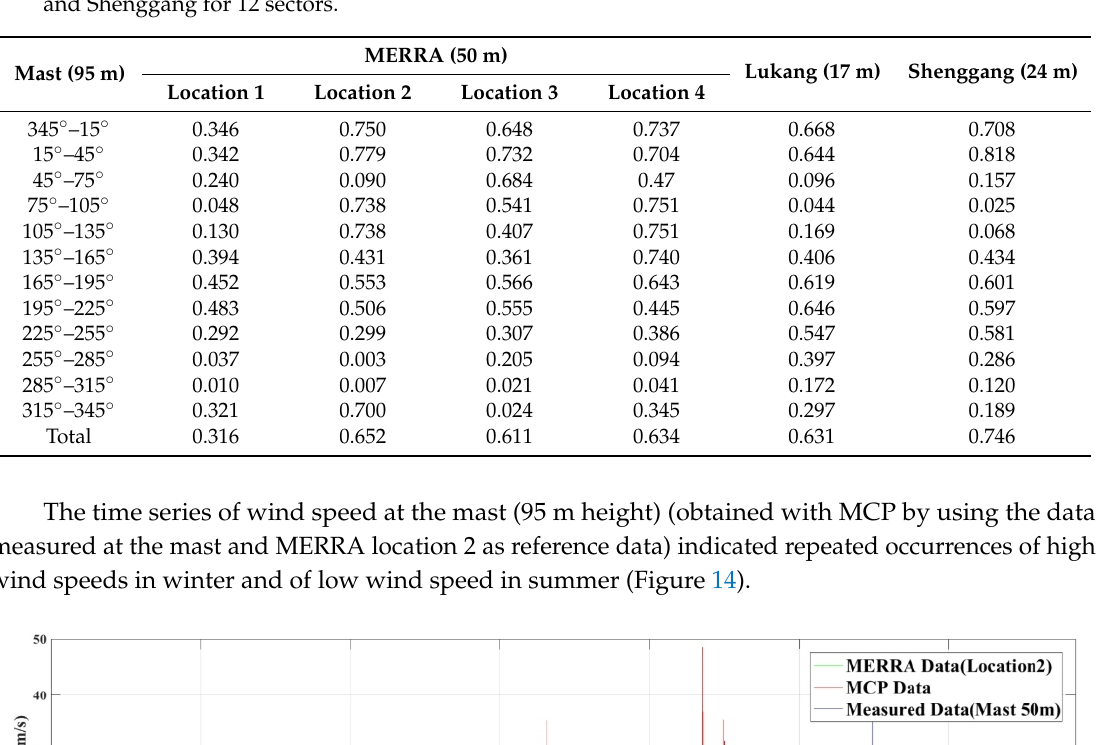
Table 6. Correlation coefficient of wind speed between mast (95 m) and MERRA 1–4 and CWB Lukang and Shenggang for 12 sectors.